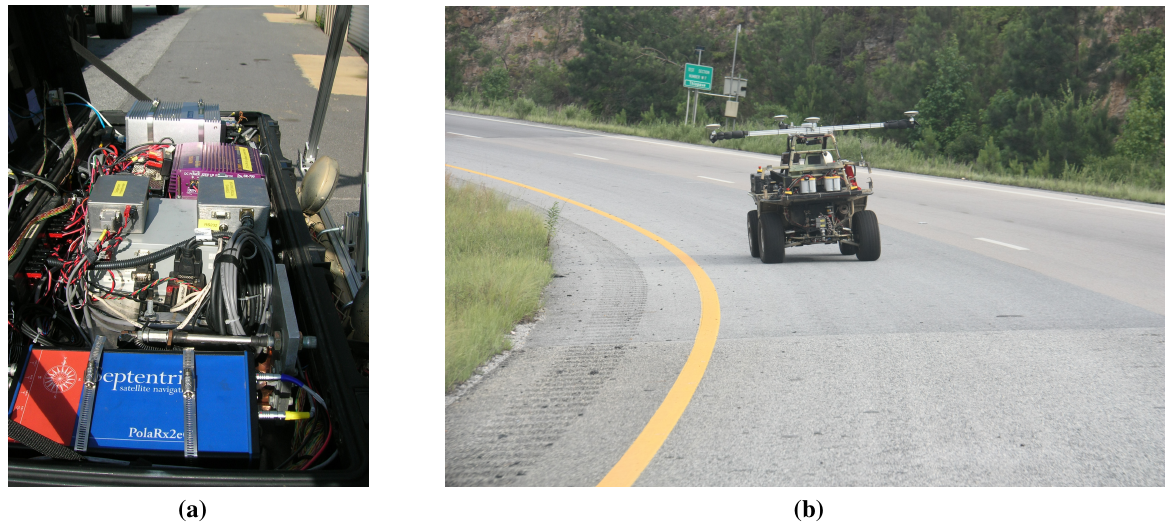
Figure 7. Sensor logging and National Center for Asphalt Technology (NCAT) banked turn. ( a ) Sensor logging; ( b ) NCAT oval eight-degree banked